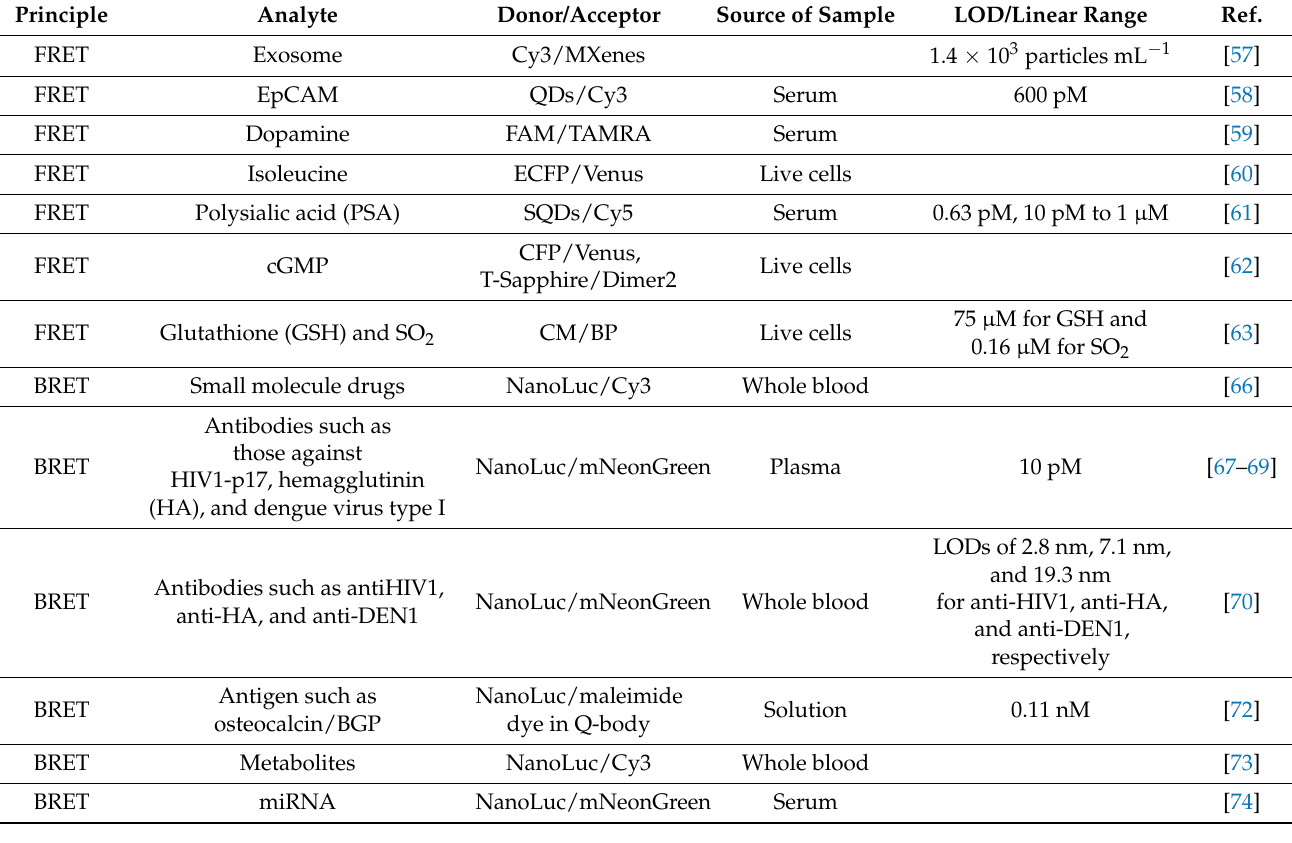
Table 2. FRET- and BRET-based biosensors for bioassay and